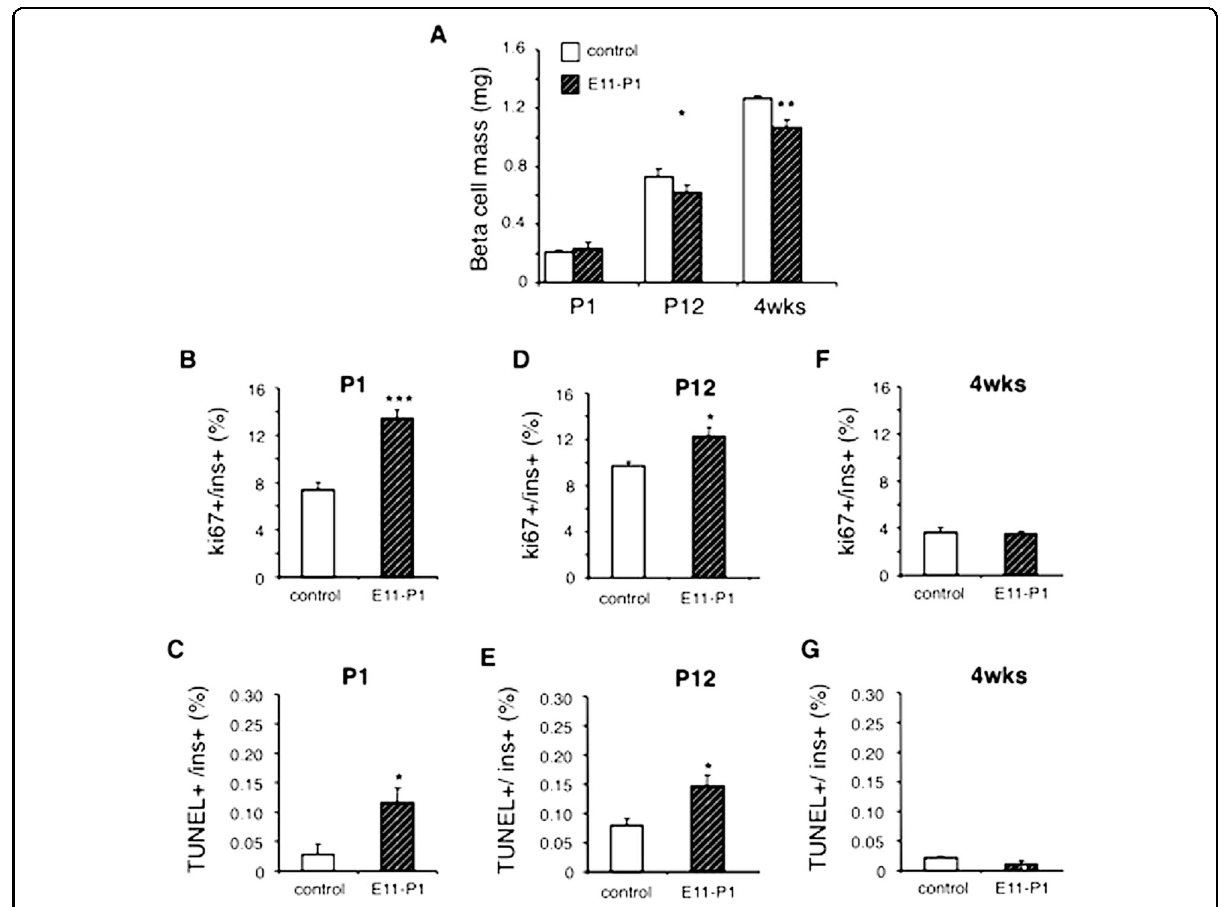
Fig. 6 Effect of Δ NI κ B α induced expression in insulin-producing cells during the embryonic period on β -cell mass, β -cell proliferation, and apoptosis in non-diabetic transgenic ToI β mice. A BCM was determined by immunostaining for insulin and is presented in milligrams. B , D , F β -cell proliferation was assessed by co-staining for Ki67, insulin, and calculated as a percent of Ki67-positive nuclei in insulin-positive cells out of the total number of insulin-positive cells per mouse. B P1 ( n = 5, ~6100 β -cells); D P12, ( n = 4, ~8800 β -cells); F 4 weeks ( n = 3 – 4, ~11,150 β -cells). C , E , G β -cell apoptosis was assessed using TUNEL assay and co-staining for insulin and calculated as a percent of TUNEL-positive nuclei in insulin-positive cells out of the total number of insulin-positive cells per mouse. C P1 ( n = 5 – 6, ~5160 β -cells; E P12 ( n = 4, ~13,250 β -cells); G 4 weeks ( n = 3 – 4, ~19,000 cells). Values are mean ± SEM. * P < 0.05, ** P < 0.009, *** P < 0.0004 vs